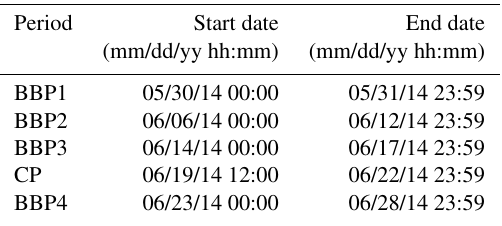
Figure 1. All satellite-detected fires with >50% detection confi- dence in June 2014 in Australia. Trajectory densities are shown as shaded regions (blue: >10% of all data; cyan: >1% of all data; green:>0.1% of all data). Table 2. The start and end dates for the four identified biomass burn- ing periods (BBP1, BBP2, BBP3 and BBP4) and the coastal period